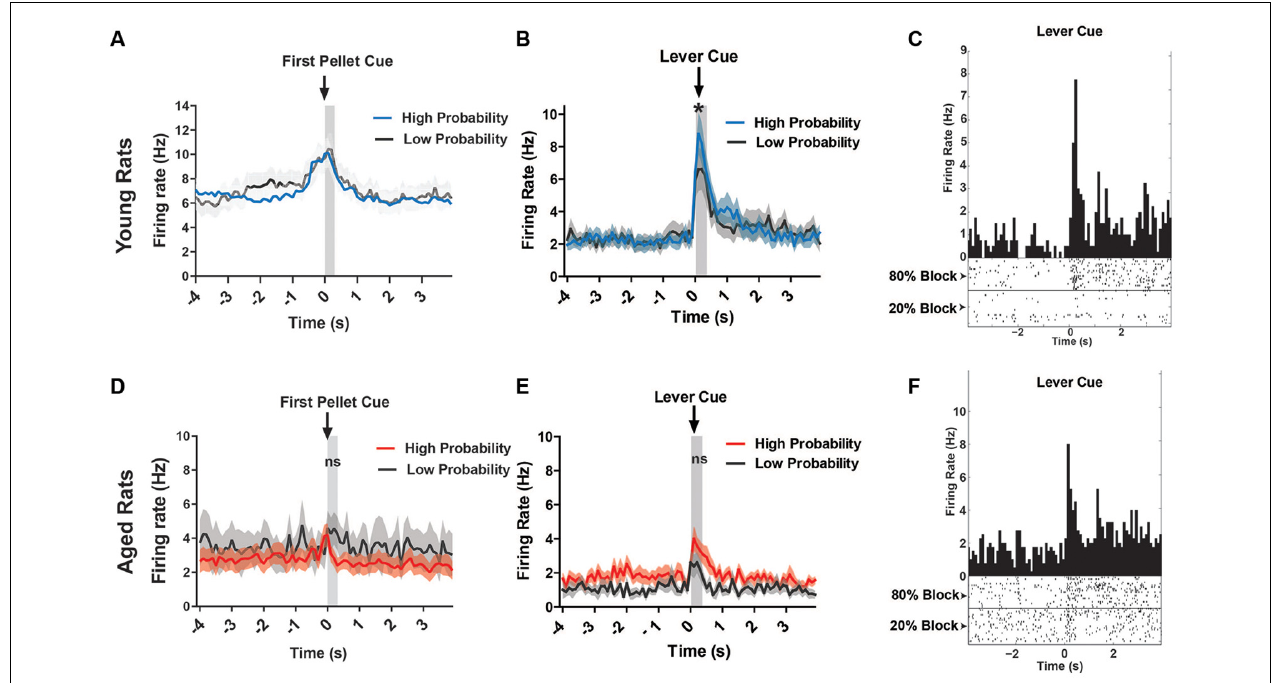
FIGURE 6 | (A) Mean firing rate (Hz) of young rats’ VTA neurons ( n = 151) centered around the first pellet cue ( ± 4.0 s). (B) Mean firing rate (Hz) of young rats’ lever excited VTA (DA + nonDA) neurons ( n = 37) centered around the lever cue ( ± 4.0 s). Blue traces indicate responses during the 80% block; gray traces represent the 20% block. The neurons displayed significantly greater firing rate responses to the lever cue during the high probability block compared to the low probability block (one-tailed dependent t -test, t (36) = 1.73, p = 0.04). (C) Peri-event time histogram (PETH) of a lever excited young neuron’s responses to the lever cue during high and low probability blocks. Left Y-axis represents the mean firing rate (Hz) over all the events; time 0 indicates the onset of lever cue. Raster diagrams show individual spikes around the lever cue. Top: 80% block; bottom: 20% block. (D) Mean firing rate (Hz) of aged rats’ VTA neurons ( n = 107) centered around the first pellet cue ( ± 4.0 s). (E) Mean firing rate (Hz) of aged rats’ lever excited VTA (DA + nonDA) neurons ( n = 9) centered around the lever cue ( ± 4.0 s). Red traces indicate responses during the 80% block; gray traces represent the 20% block. The neurons did not display a significant difference in firing rate between the two probability blocks (one-tailed dependent t -test, t (8) = 0.09, p = 0.46). (F) PETH of a lever excited aged neuron’s responses to the lever cue during high and low probability blocks. Left Y-axis represents the mean firing rate (Hz) over all the events; time 0 indicates the onset of lever cue. Raster diagrams show individual spikes around the lever cue. Top: 80% block; bottom: 20% block. * p < 0.05; ns = not significant, p >